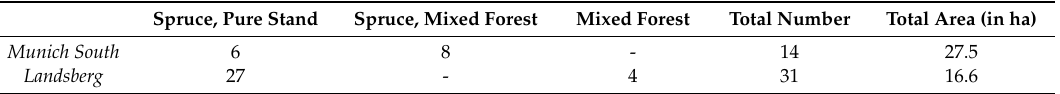
Table 3. Number of reference polygons obtained from field surveys per affected forest type. The total area of the reference polygons is also indicated.